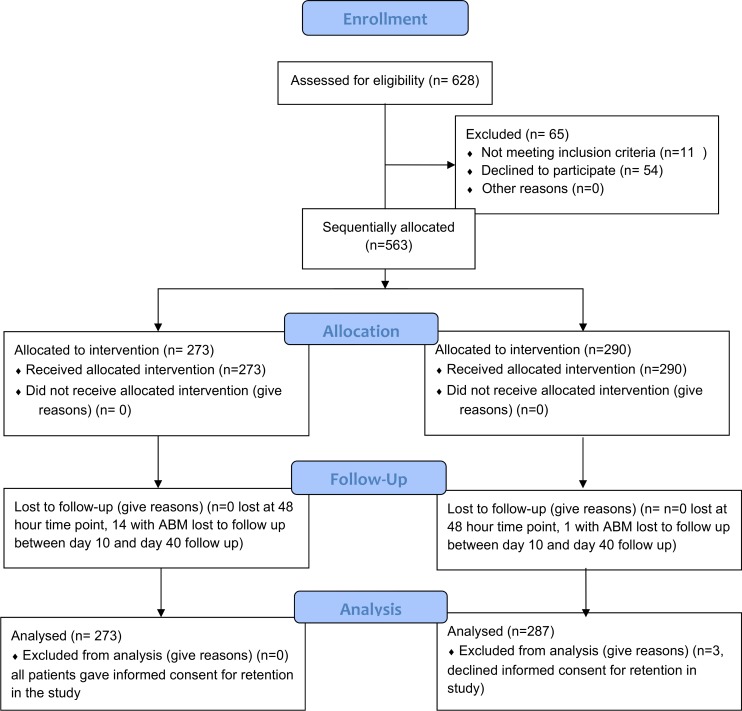
Enrolment of all participants with suspected bacterial meningitis.